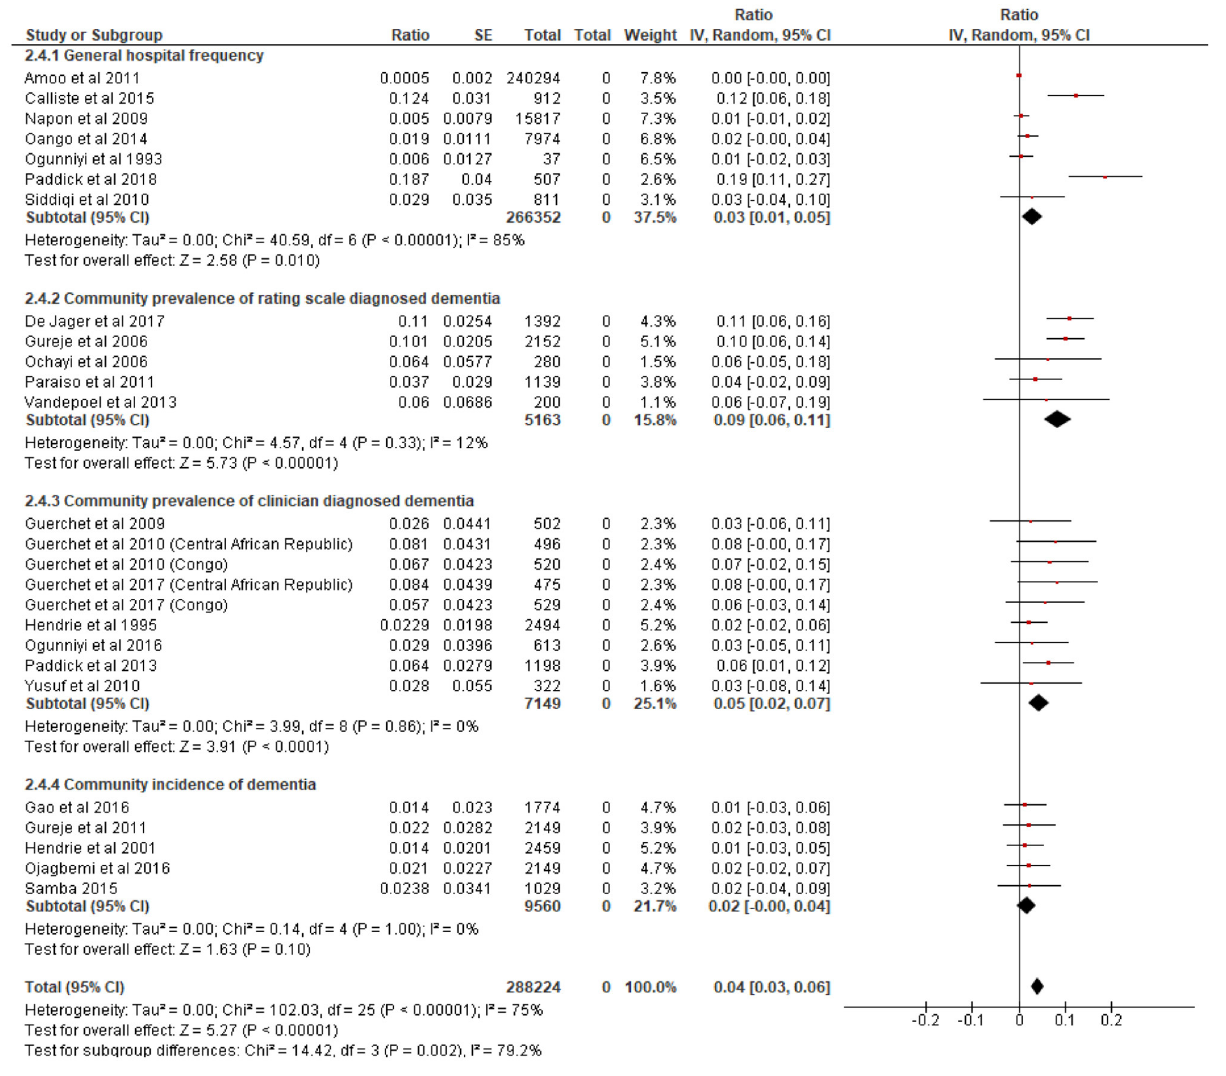
FIGURE 2 | Forest plot showing hospital frequency, community prevalence and incidence of dementia in sub-Saharan Africa. We centered the display of the estimates on the point of zero for better